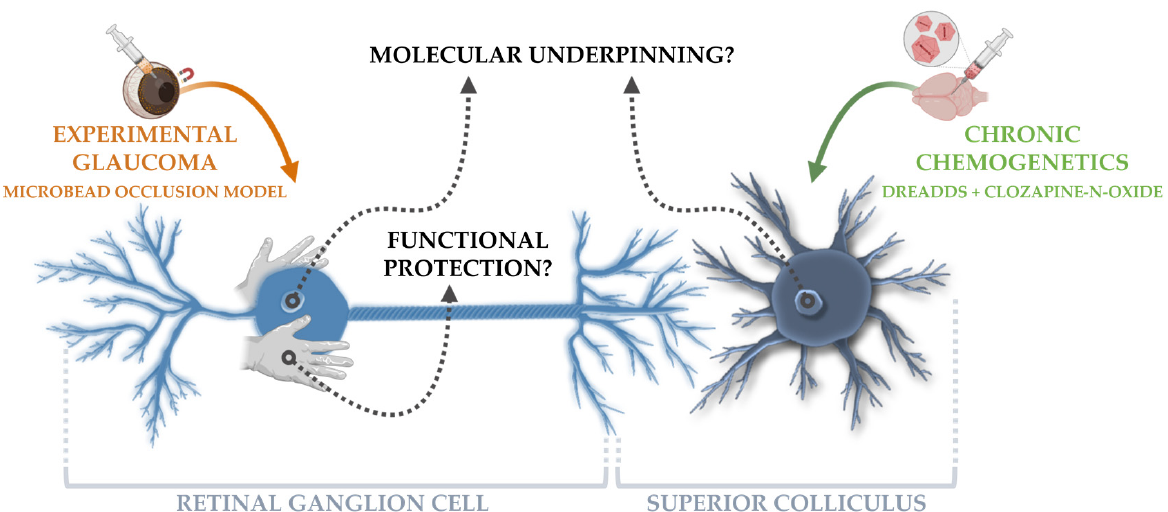
Figure 1. Brief overview of the study design. To explore the role of chronic target activation on the health of retinal ganglion cells (RGCs) upon glaucomatous injury, the microbead occlusion model was used to induce a glaucomatous-like pathology in the murine eye and the DREADD toolbox was applied in the superior colliculus as a chronic chemogenetic neuromodulation tool. Next, the molecular underpinning of these techniques was evaluated via bulk RNA sequencing on collicular lysates and isolated RGCs, whilst probing the functionality of injured